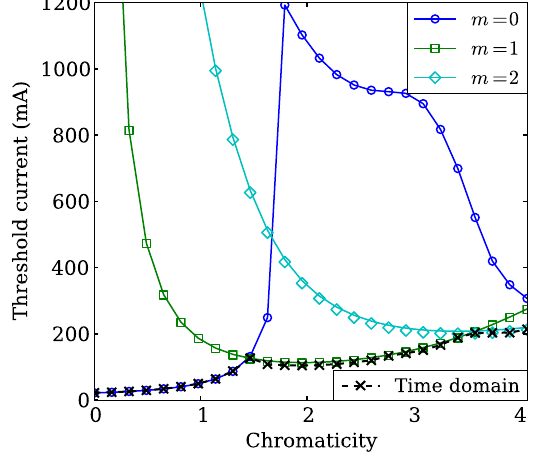
FIG. 2. Threshold current for the coupled-bunch resistive-wall instability for the case with a short bunch in a single rf system. Results of macroparticle simulations in the time domain (dashed line) are compared with those obtained using a frequency domain computation (solid lines).